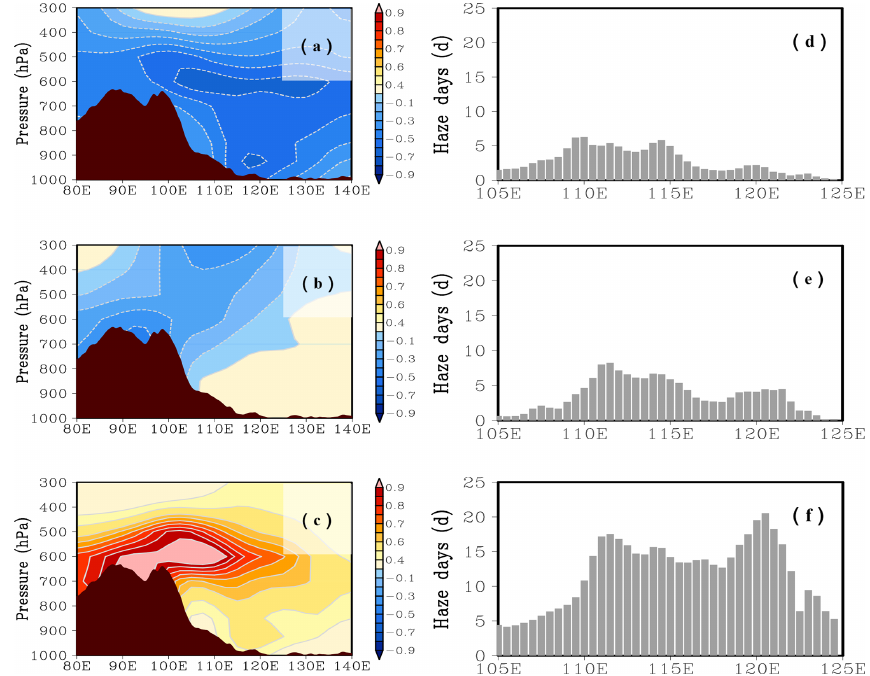
Figure 4. Vertical cross sections of (a–c) air temperature anomalies (unit: ◦ C) and (d–f) the number of haze days averaged along 25–40 ◦ N in winter from 1961–1980 (a, d) , 1981–2000 (b, e) and 2001–2018 (c, f) .